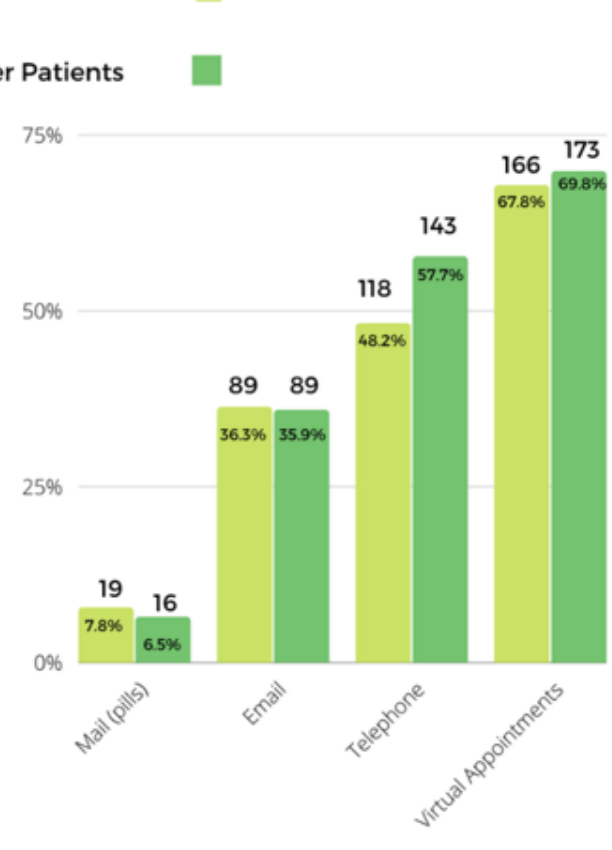
Figure 3. Telemedicine use and non-contact medication delivery among survey participants.